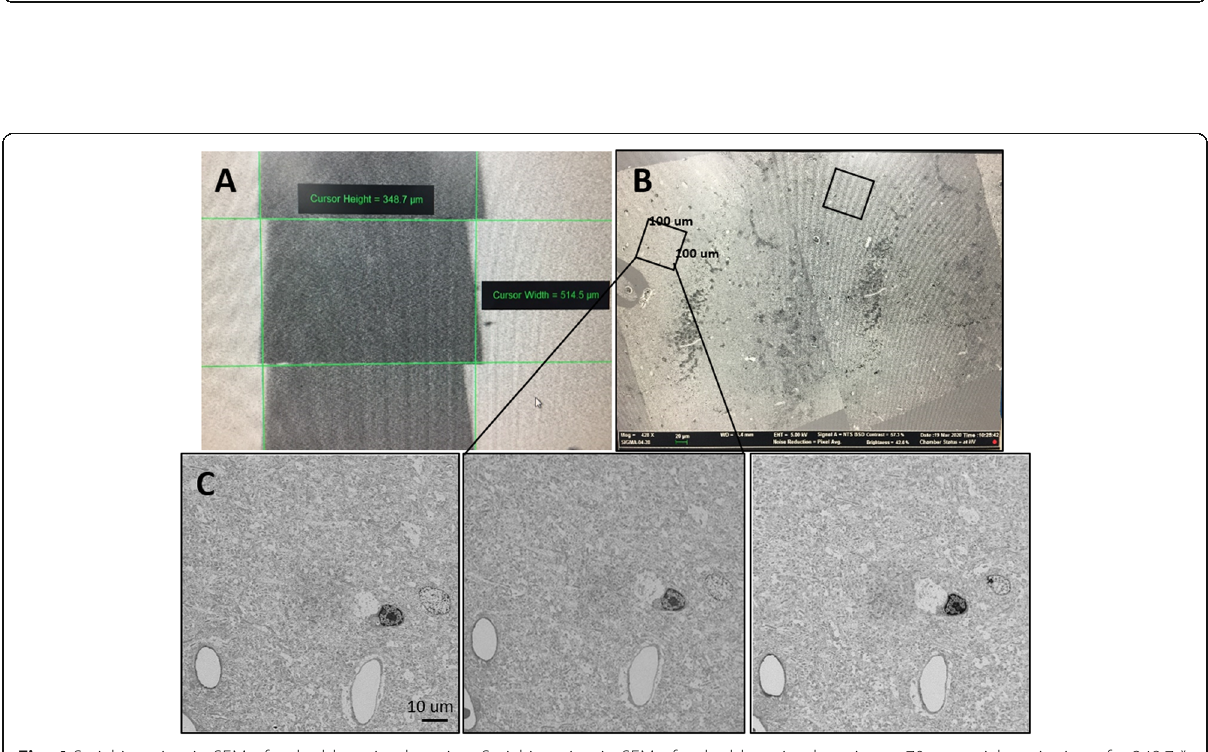
Fig. 4 Serial imaging in SEM of a double-stained section. Serial imaging in SEM of a double-stained section. a 70 nm serial sectioning of a 348.7 * 514.4 μ m area. b Selection of the SEM area of interest. c 3 Serial imaging of a 100 * 100 μ m area using the ATLAS